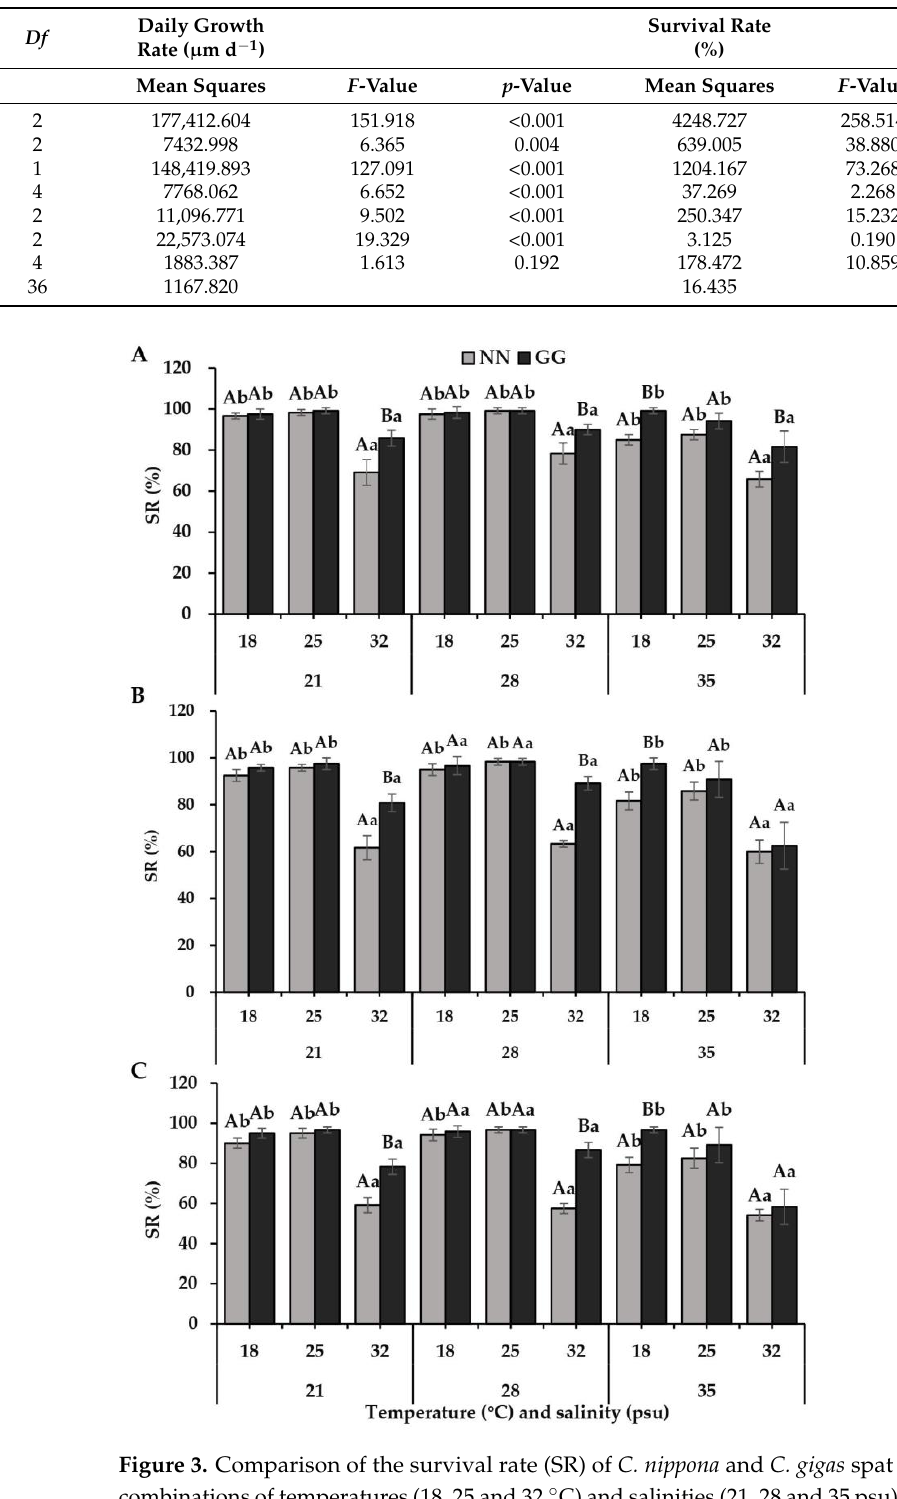
Table 2. Analysis of variance (three-way ANOVA) testing the factor effects (temperature, salinity and species) on the daily growth and survival rates of spat.